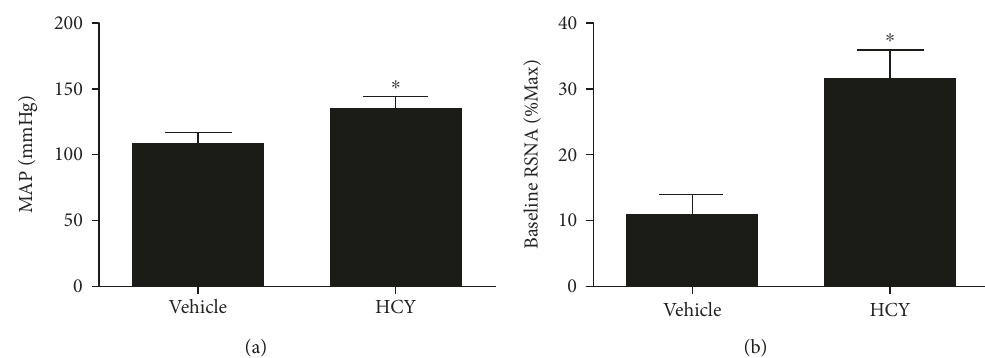
Figure 2: Levels of BP (a) and basal RSNA (b) obtained in anesthetized rats with L-methionine treatment. n = 5 /group. ∗ P < 0 05 versus the vehicle group.